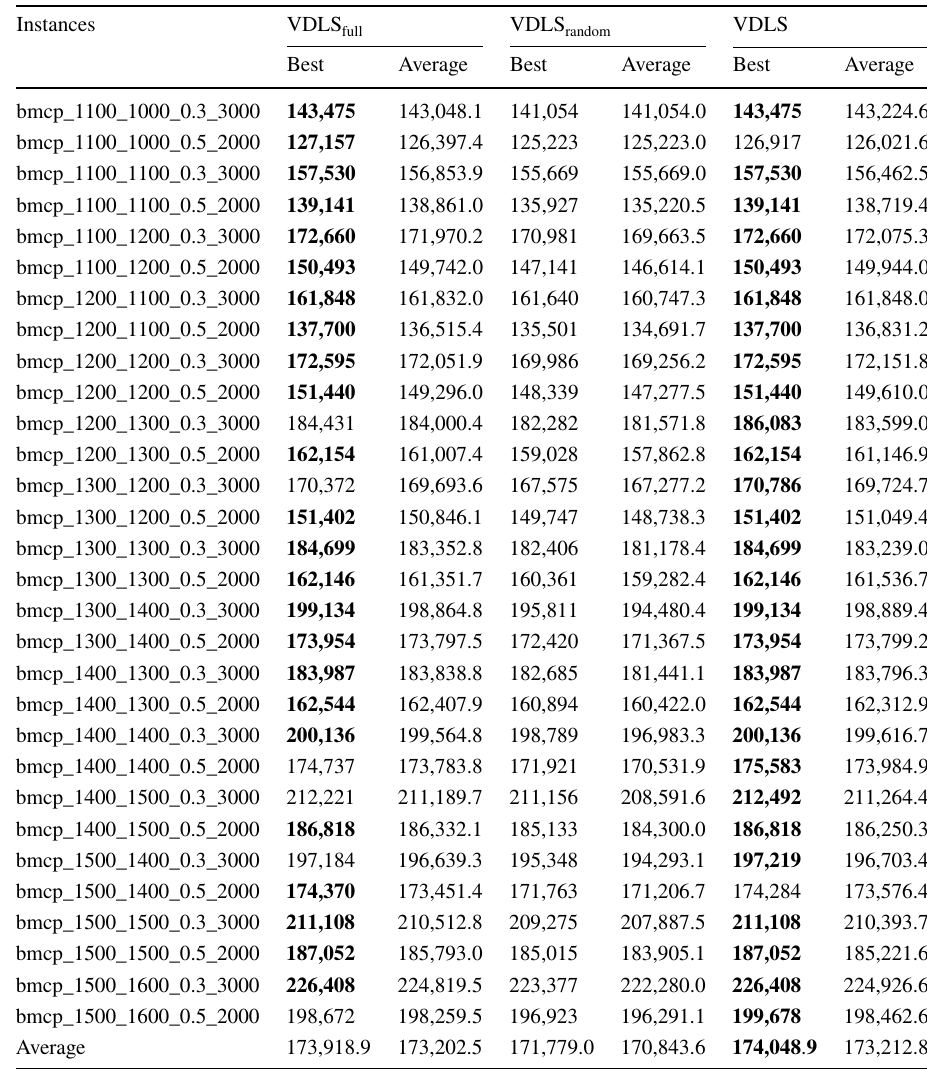
Best results appear